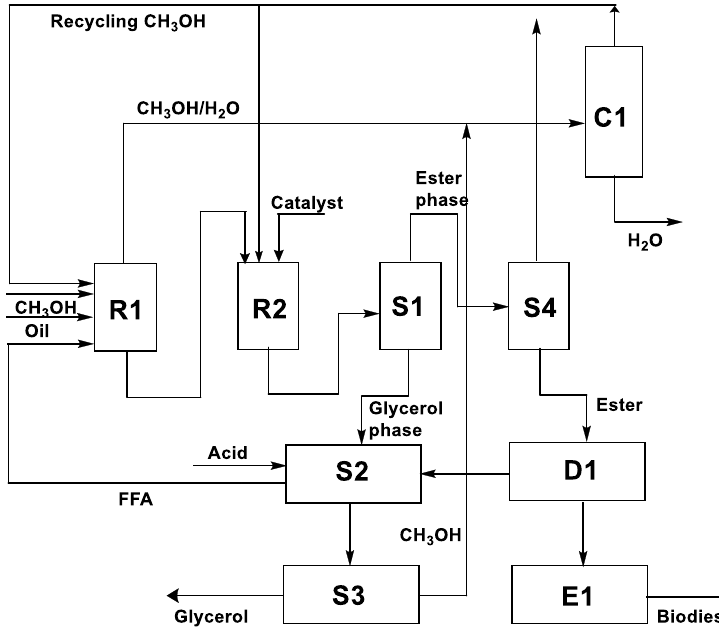
Figure 3. Biodiesel and glycerol produced in flow reactors.